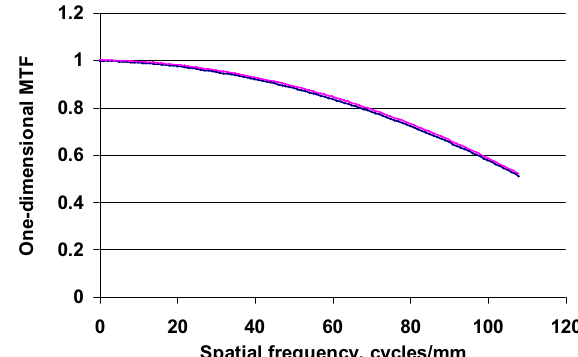
Fig. 5. Ratio of the experimentally obtained two-dimensional MTF to the theoretically calculated MTF.